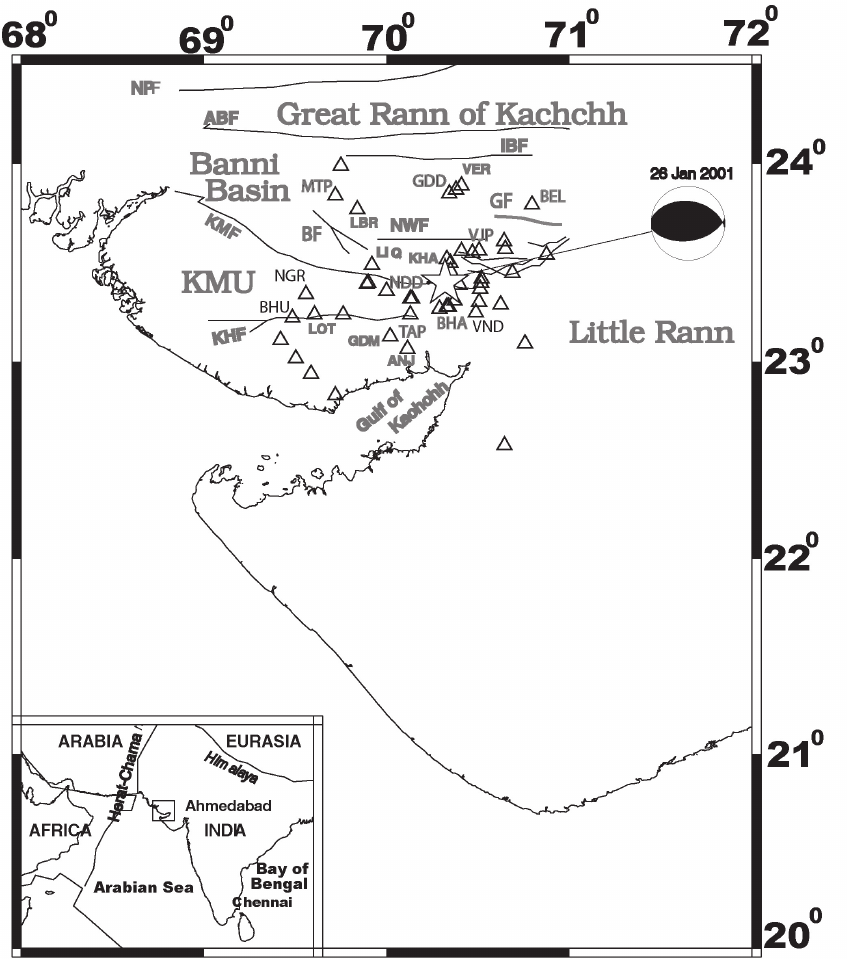
Fig. 1. Location map of 58 seismograph stations (marked by open triangles) in the Kachchh rift zone, Gujarat. KMU: Kachchh mainland uplift; ABF: Allah Bund Fault; IBF: Island belt fault; KMF: Kachchh mainland fault; KHF: Katrol Hill fault; NPF: Nagar Parkar fault; NWF: North Wagad fault; BF: Banni Fault; GF: Gedi Fault. The inset shows the study area (marked by rectangle) with reference to the Indian plate boundaries (dark lines). The location of Chennai and Ahmedabad cities are also